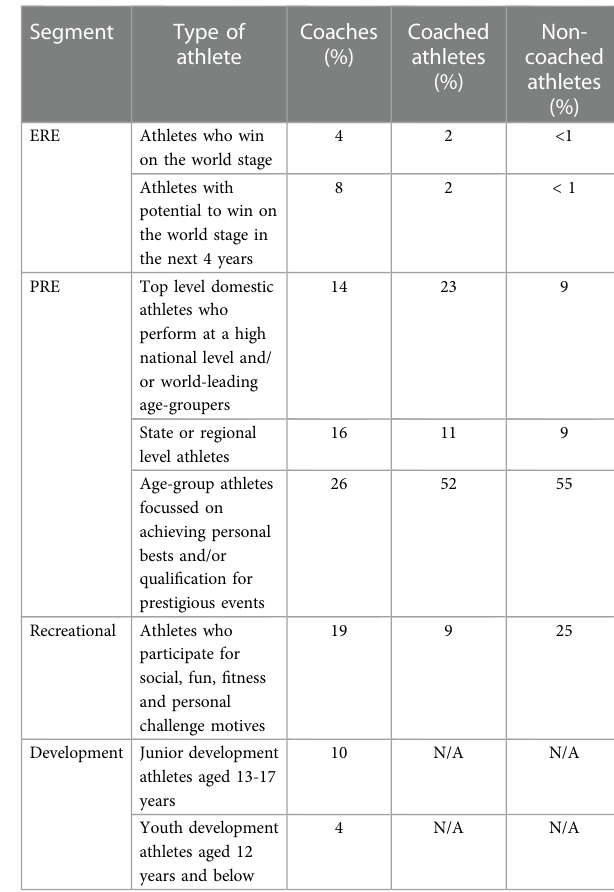
TABLE 2 Segments and types of athlete (ERE, elite referenced excellence; PRE, personal referenced